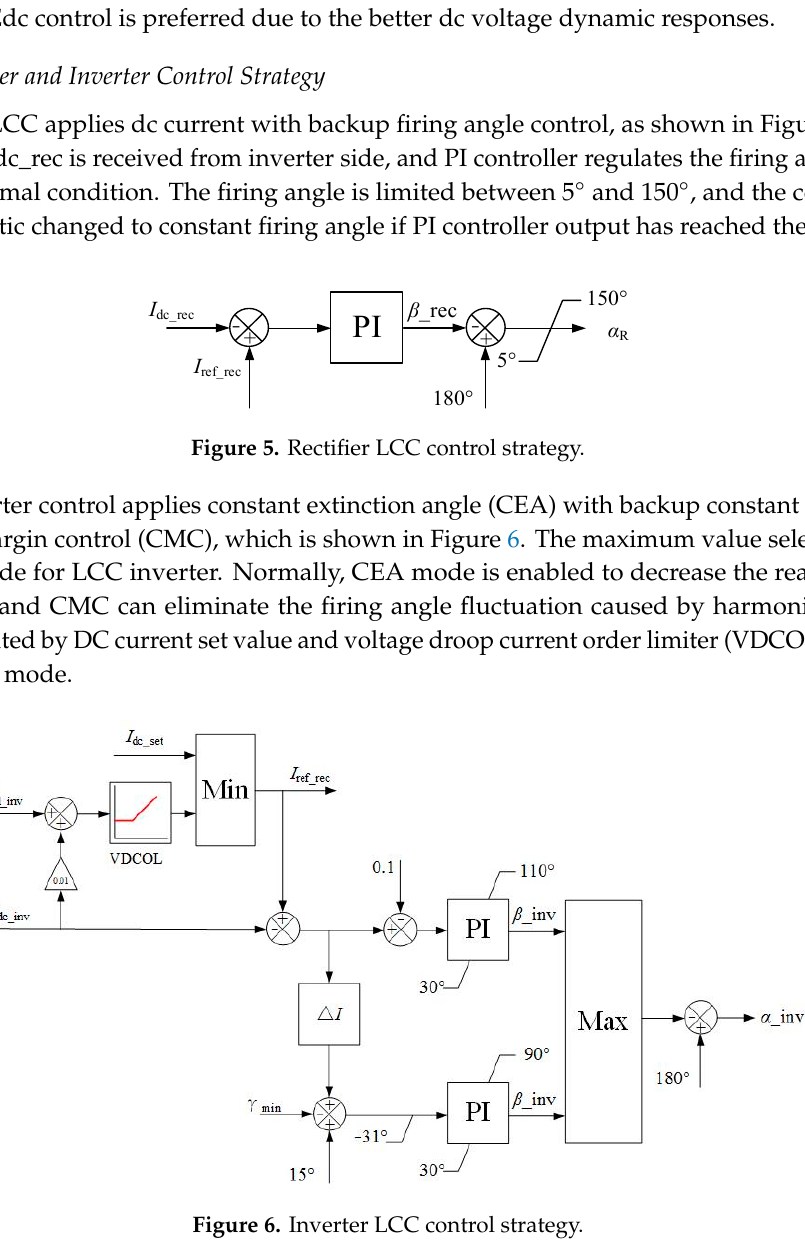
Figure 4. HB-MMC equivalent circuit.